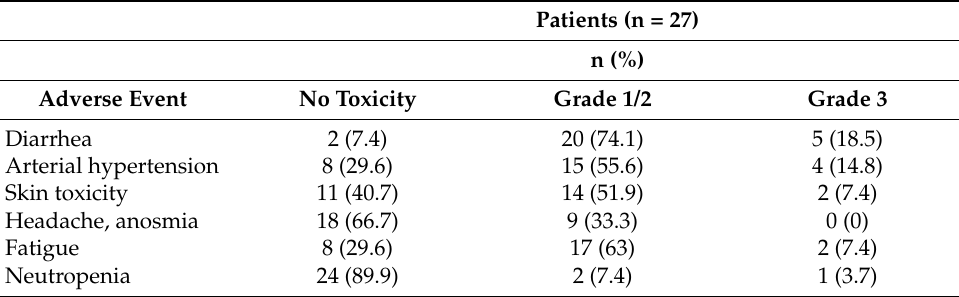
Table 2. Adverse events graded according to standard CTCAE 6.0